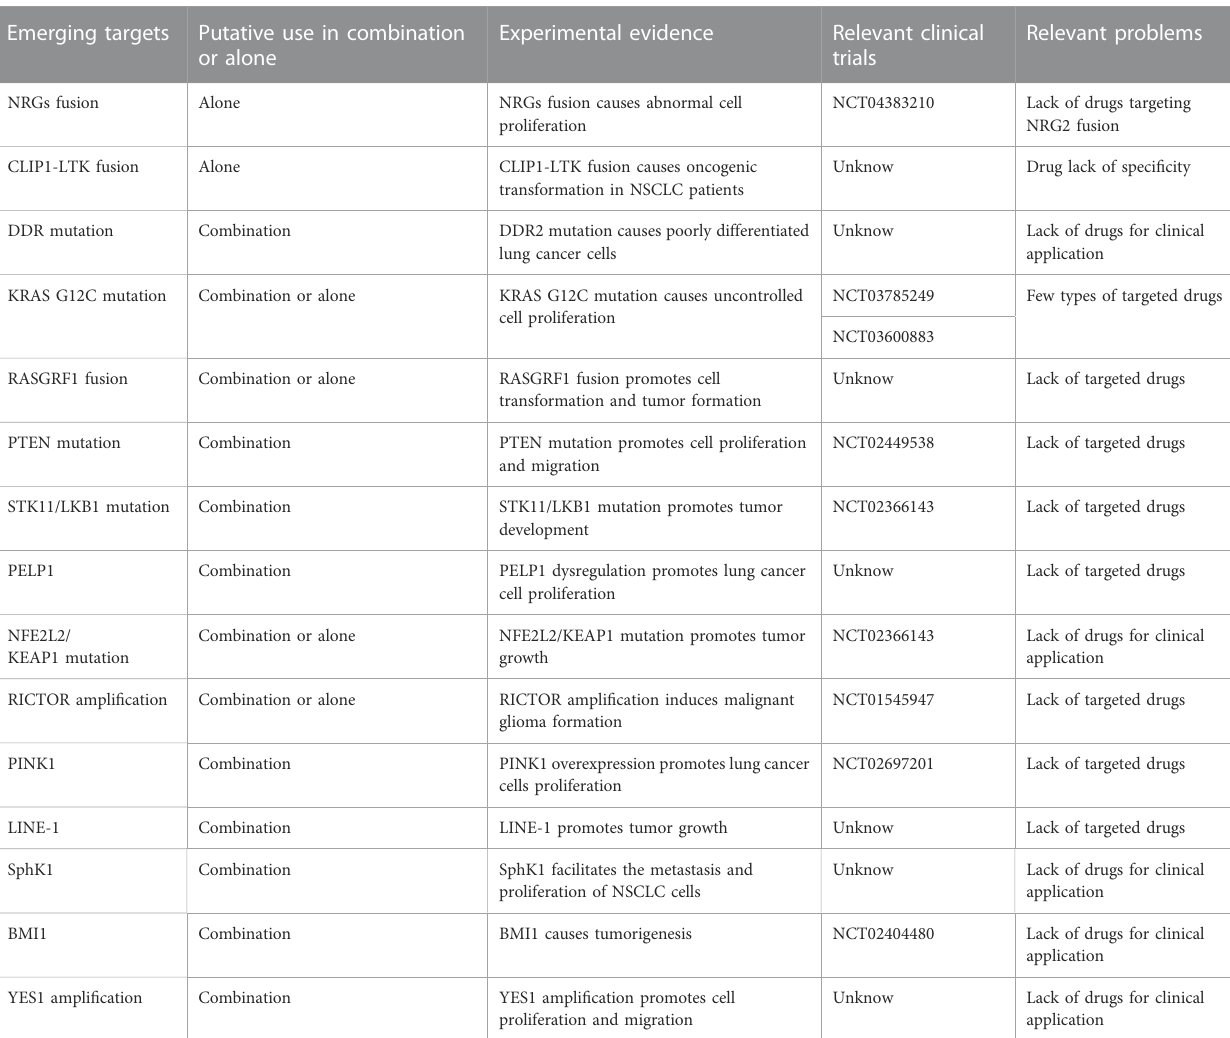
TABLE 3 Summary of emerging targets. Emerging